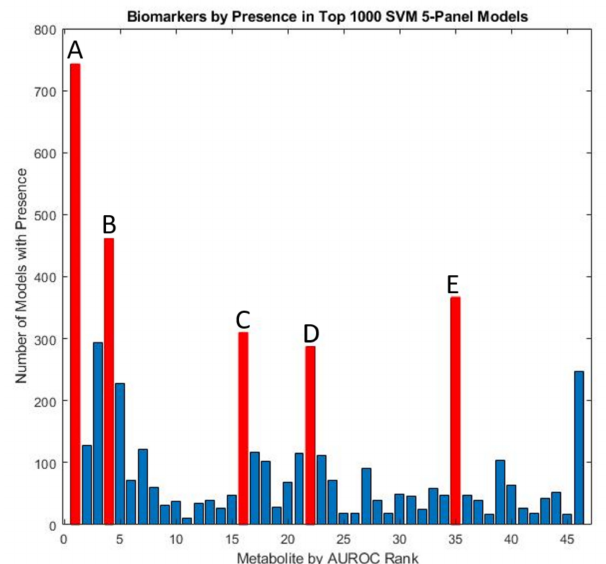
Figure 6. Marker prevalence among the top 1000 4-marker FDA models as judged by their perfor- mance on the test set, with both total and free sulfate excluded. Due to the predominance of sulfate in model panels, models with other constituents were explored by conducting the FDA analysis with these two metabolites excluded. The metabolites observed to be most prevalent in the resulting models were highlighted in red and include ( A ) glutathione present in 43.3% ( B ) uridine present in 74.7%, and ( C ) homocystine + homocysteine present in 32.1% of models.